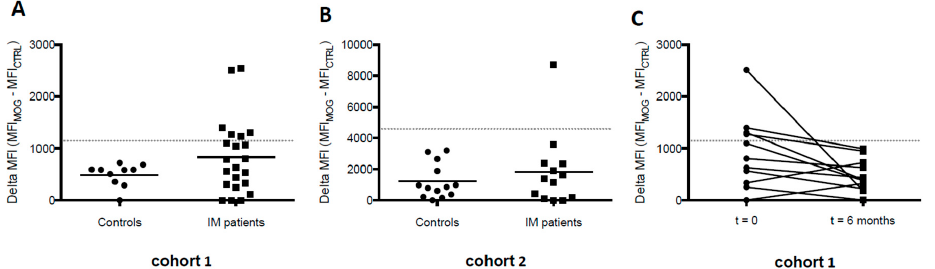
Figure 1. Elevated myelin oligodendrocyte glycoprotein (MOG)-specific immunoglobulin G (IgG) responses during acute infectious mononucleosis (IM). Serum anti-MOG IgG reactivity of control and IM patient sera from cohort 1 ( A ) and cohort 2 ( B ) was detected at time of diagnosis. The positivity threshold, designated with a grey dotted line, was determined by three standard deviations above the mean of the control samples; ( C ) MOG-specific IgG responses disappear six months post IM